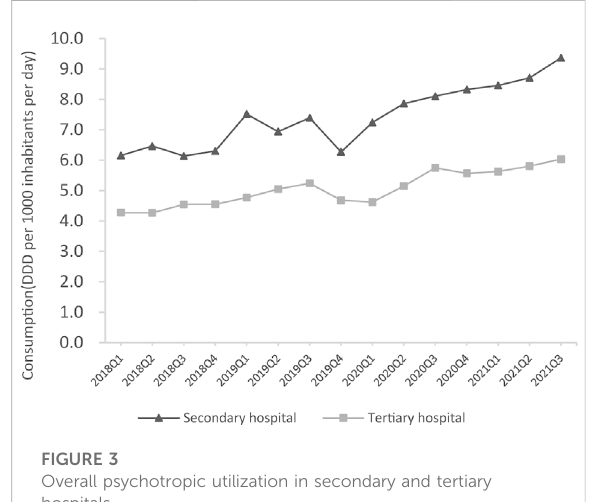
FIGURE 3 Overall psychotropic utilization in secondary and tertiary